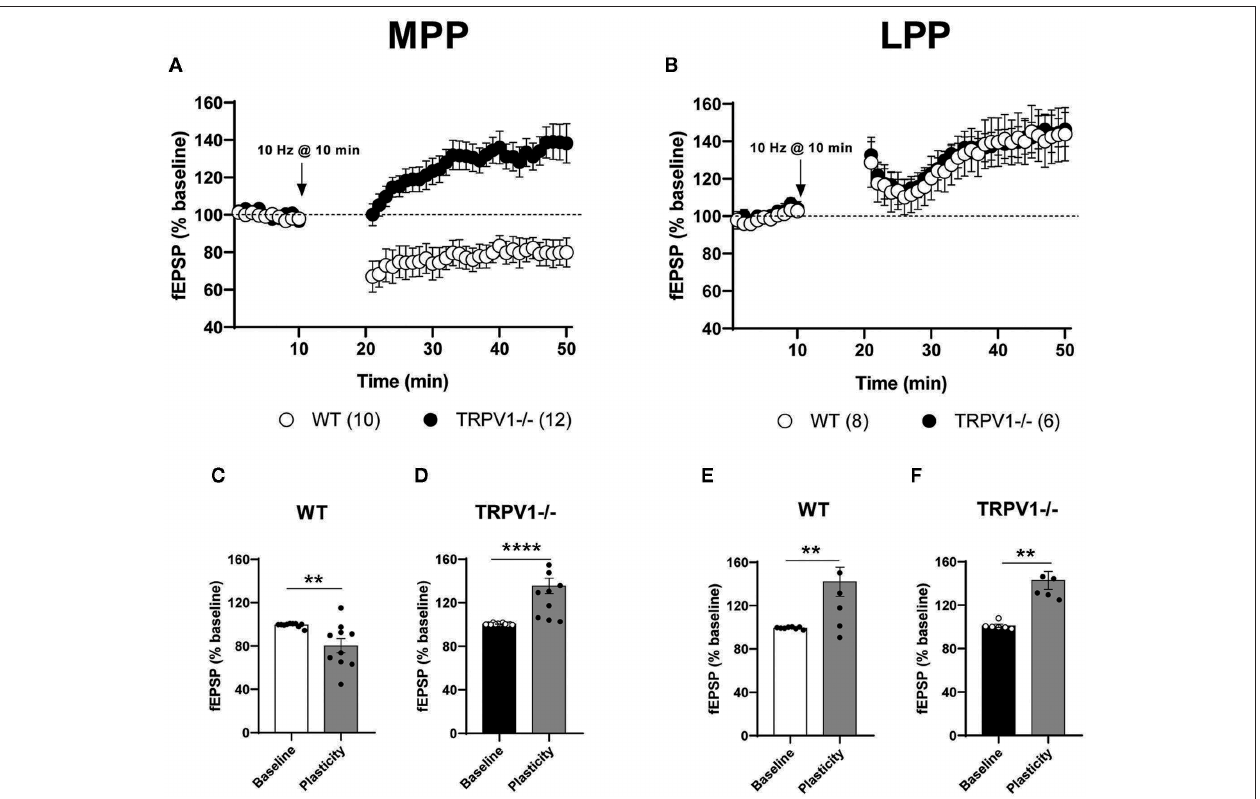
FIGURE 2 | (A) Low-frequency stimulation (LFS) triggers long-term depression (LTD) at the medial perforant path (MPP) synapses in WT (white circles) and long-term potentiation (LTP) in TRPV1-/- (black circles). (B) Similar stimulation elicits the long-term potentiation at the lateral perforant path (LPP) in WT (white circles) and TRPV1-/- (black circles). For representation, each experiment was normalized to its baseline. The average of the fEPSP areas is shown. Arrows point to LFS application (10min, 10Hz). Representative histograms of fEPSP (last 10min) after LFS at MPP in: (C) WT (Mann–Whitney test. ** p < 0.005 vs. baseline), (D) TRPV1-/- (Mann–Whitney test. **** p < 0.0001 vs. baseline), and after LFS at LPP in (E) WT (unpaired t-test. ** p < 0.005 vs. baseline), and (F) TRPV1-/- (Mann–Whitney test. ** p < 0.005 vs. baseline). All data are expressed as mean ± SEM.